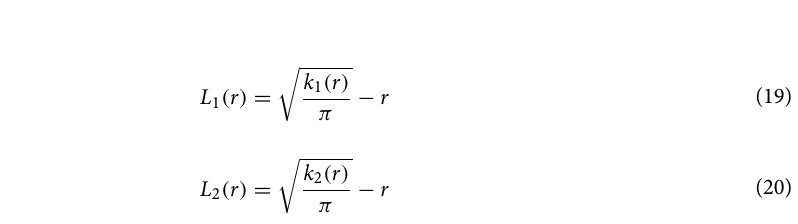
Figure 15. Plot of the L-functions L 1 ( r ) and L 2 ( r ) for samples a2, b2, c2, d2, e2, and